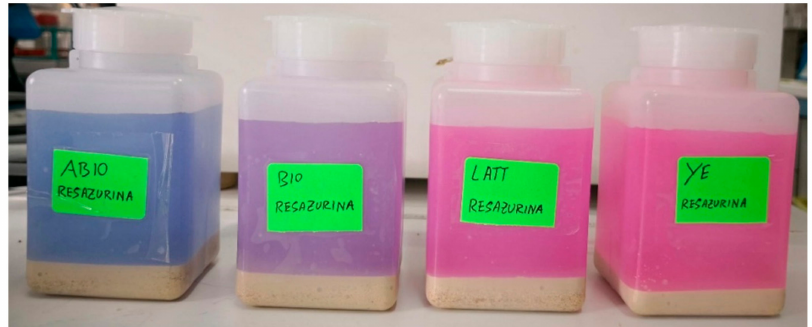
Figure 4. Resazurin control reactors at T2 (seven days of